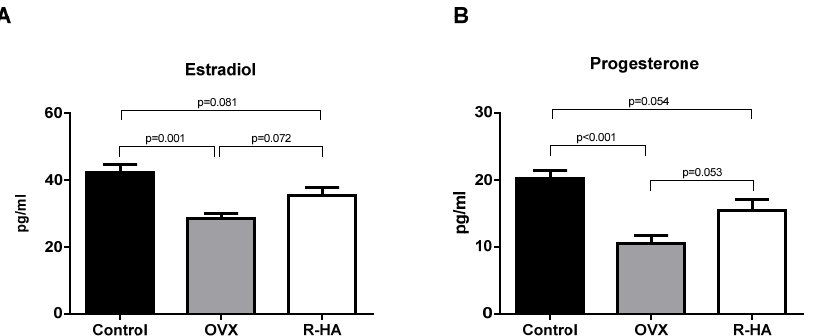
Figure 1. Serum sex hormones levels in control, OVX, and after 4 weeks of R-HA administration (( A )—estradiol; ( B )—progesterone). Data are presented as the M ± SEM. One-way ANOVA with post hoc Tukey’s test for multiple comparisons was performed for data analysis.